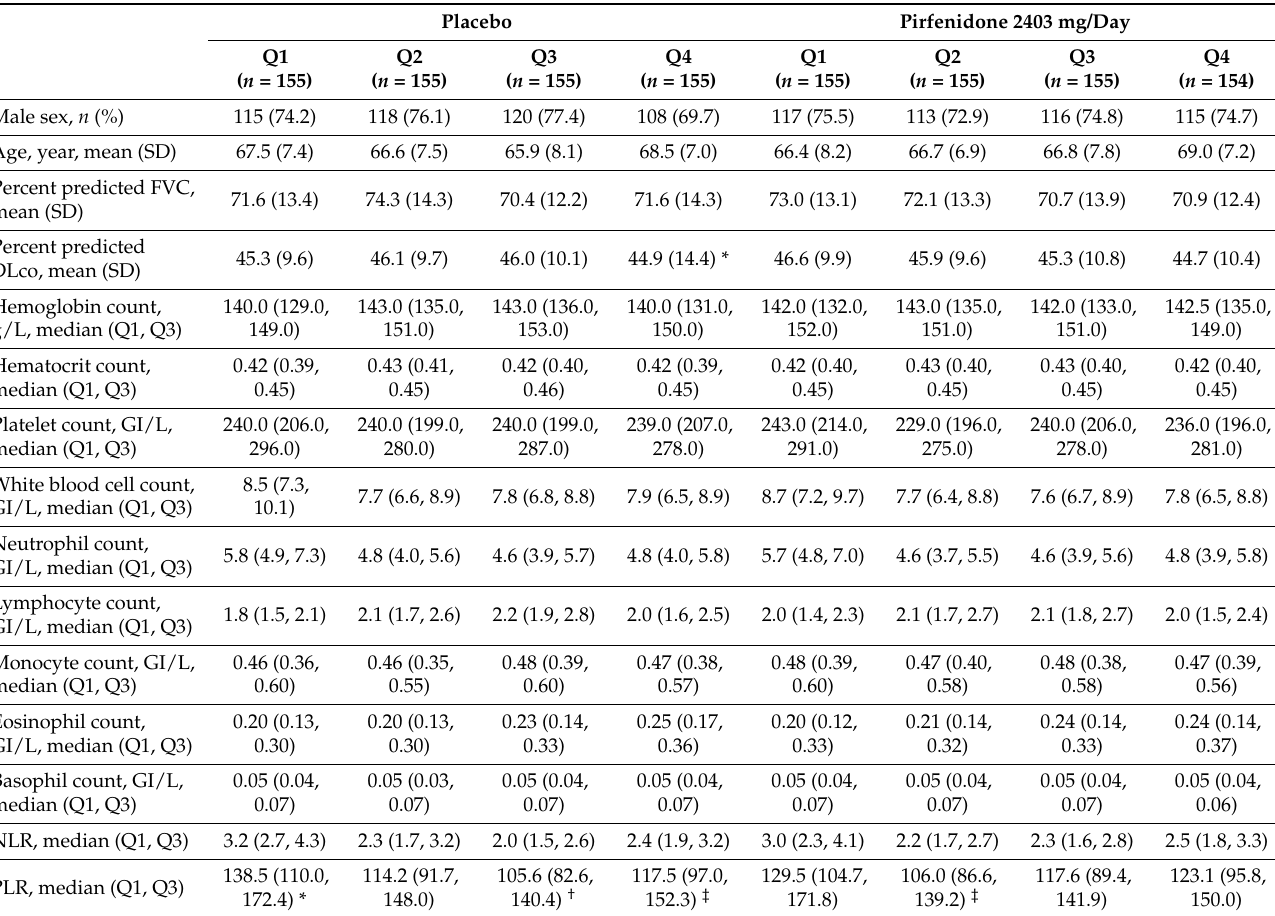
Table 1. Baseline demographics and clinical characteristics of patients included in ASCEND and CAPACITY (placebo and pirfenidone 2403 mg/day groups), by change from baseline to Month 12 in NLR.